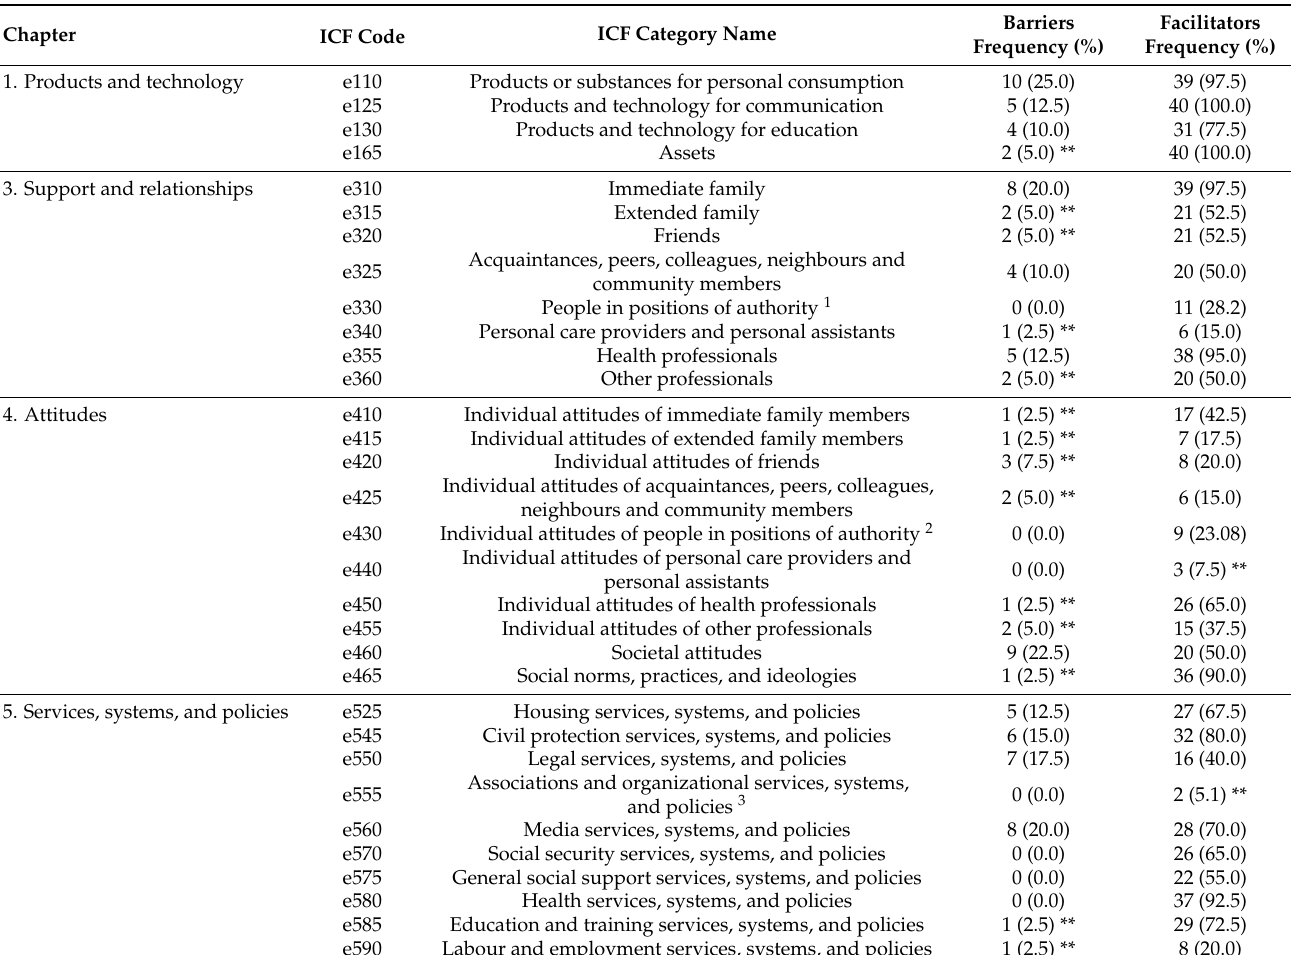
Table 4. Frequency and percentage of participants with environmental barriers and/or facilitators * on the ICF categories of the Environmental factors